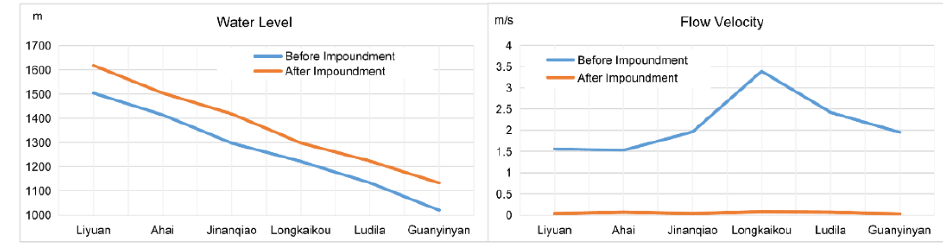
Figure 6. Changes in water level in front of dams and velocity in reservoirs after cascade hydropower development on the middle reaches of the Jinsha River.